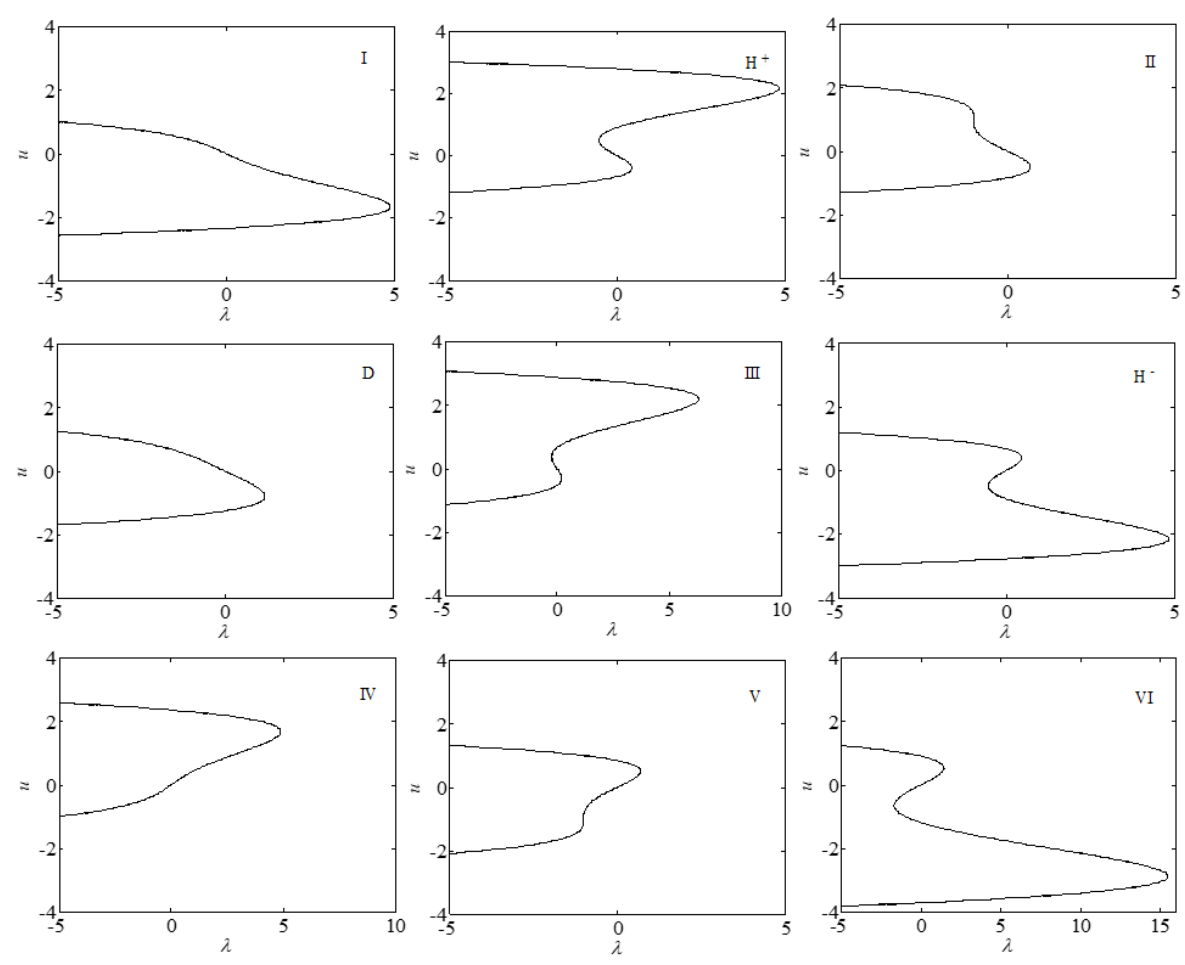
Figure 19. Topological structure of different areas in the transfer set with d 2 = 0.